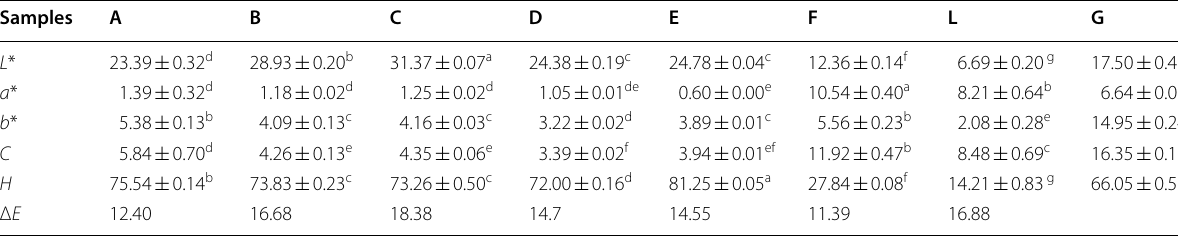
Mean standard deviation for three determinations. Values with the different superscripts on a row are significantly different at p < 0.05 ± CSF: corn silk flour; LF: lemon flour; A: 100% CSF; B: 95% CSF and 5% LF; C: 90% CSF and 10% LF; D: 85% CSF and 15% LF; E: 80% CSF and 20% LF; F: top tea; G: green tea; L: Lipton tea L *: lightness factor; a *: redness factor; b *: yellowness factor; ∆ E : overall differences in colour